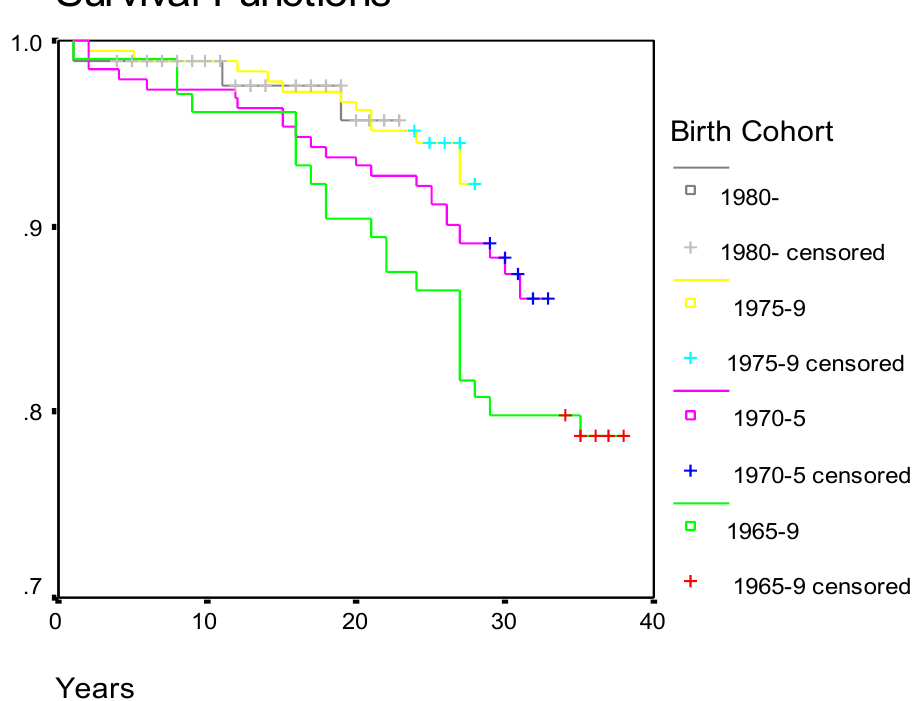
Figure 2. Survival of patients with β -thalassaemia in Cyprus according to birth cohort.